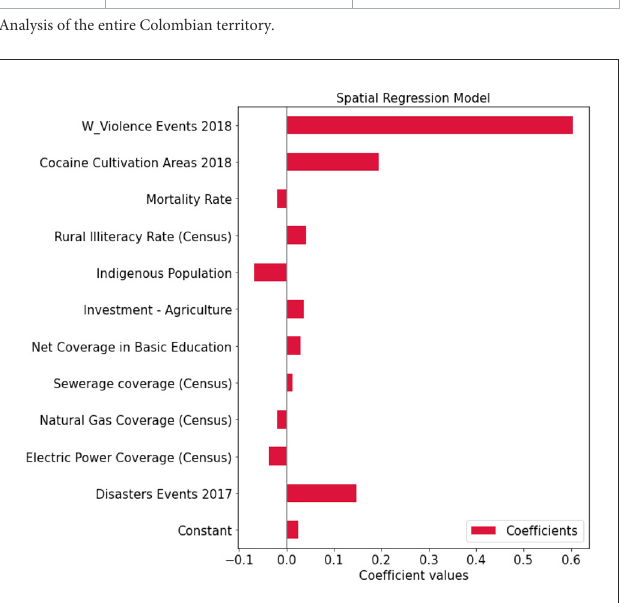
FIGURE6 Regression coefficients—analysis on the entire colombian territory.